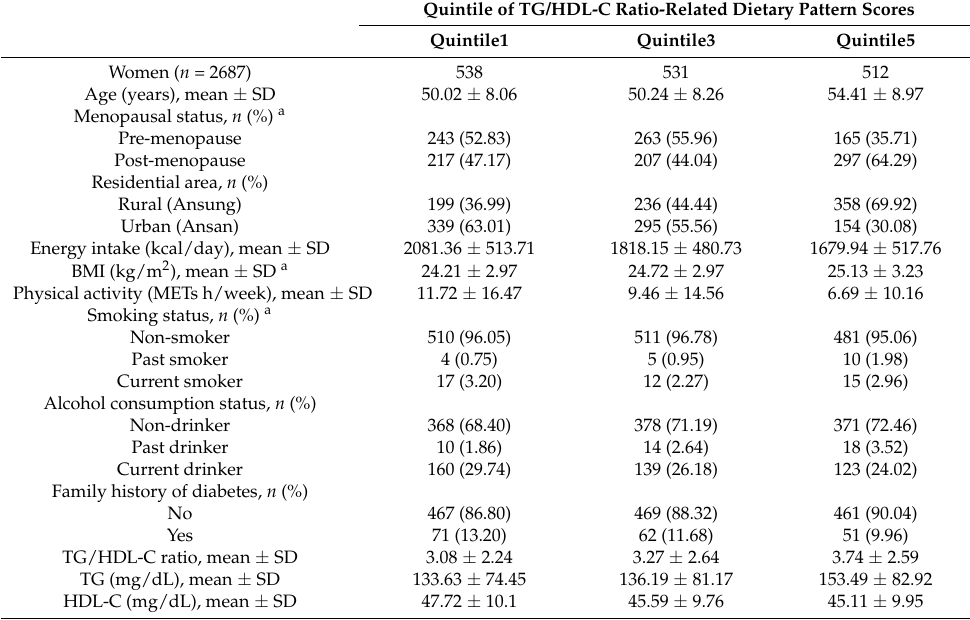
Quintile of TG/HDL-C Ratio-Related Dietary Pattern